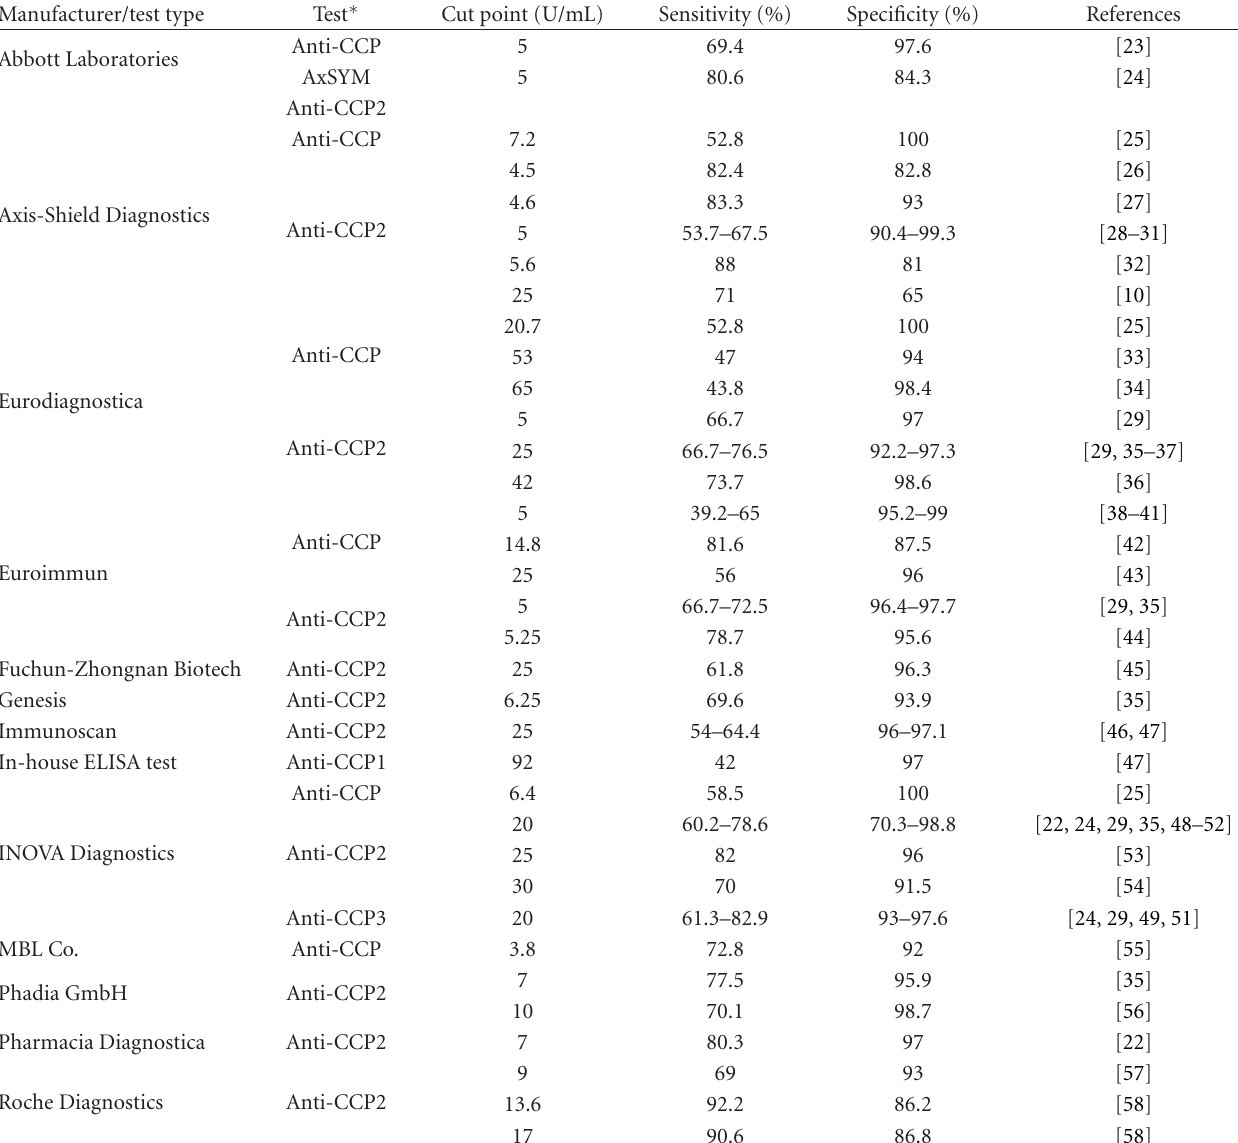
Table 2: Anti-CCP